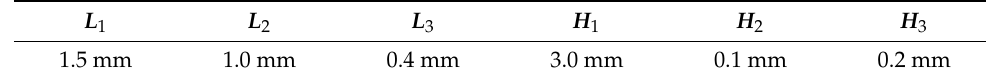
Table 1. Geometric parameters of the thermoelectric unit. L